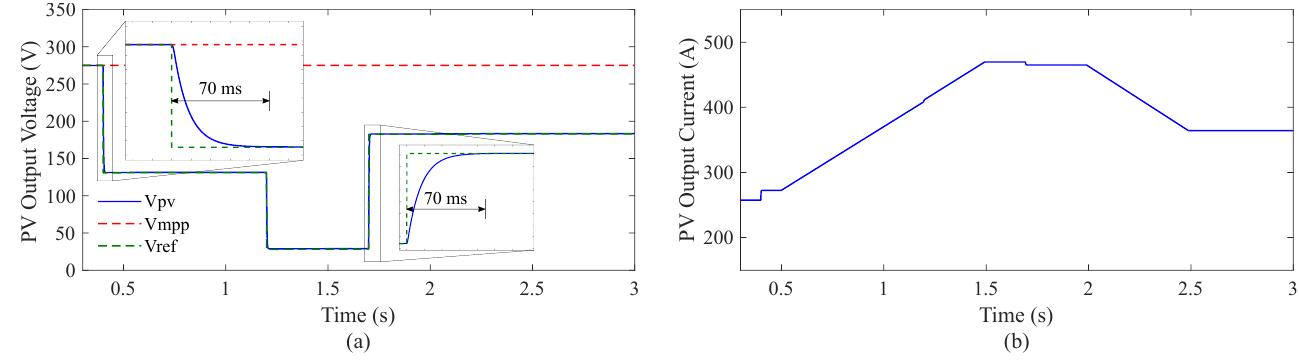
Figure 21. PV array outputs: ( a ) PV output voltage evolution, and ( b ) PV output current evolution. Figure 22 shows the results of the grid side of the PV system. In steady-state, the DC link voltage ripple is lower than 0.3%, as shown in Figure 22a,b. The worst case, with the DC link voltage (527 V) happens when the reserve command changes suddenly at 1.7 s. During this period, the DC link voltage ripple is 5.5%. Figure 22c illustrates the grid power ripple. The fluctuation of the grid power is affected by the irradiance and the reserve levels. Compared with the 90% reserve level from 1.5 s to 1.7 s, the grid power ripple at the 30% reserve level from 1.7 s to 2.0 s can be negligible. During 0.5–1.5 s and 2.0–2.5 s, the irradiance level varies continuously, causing variations of the grid power ripple value. The line grid currents are depicted in Figure 22d.